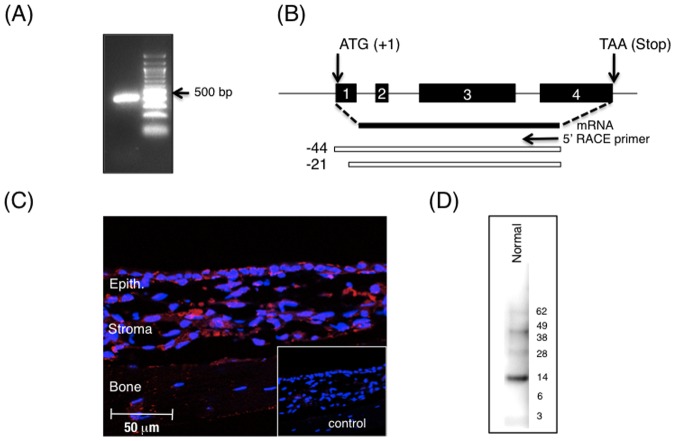
Ecrg4 is present in normal rat ME mucosa.
Panel A: Ecrg4 PCR product amplified from uninfected rat ME mucosa cDNAs. A 100 bp molecular size marker is shown on the left lane. Panel B: Organization of the rat Ecrg4 gene shows the 4 exons and the start (set to +1) and stop codons of the open reading frame (ORF). The mRNA isolated from rat ME mucosa was subjected to 5′RACE analysis using a primer annealing to exon 4 (solid arrow). Following primer elongation, cloning and sequencing of the 5′ RACE products (clear bars), translation start sites (TSS) at −42 bp and −21 bp upstream of the ATG translation start site produce the identical ORF. An asterisk denotes that the −21 bp TSS was the most frequently amplified. Panel C: Immunolocalization of Ecrg4 (red) in the ME epithelium compared to a background immunofluorescence signal using pre-immune IgY (insert). Nuclei are counterstained with DAPI (blue). Epith.  =  epithelial cells (D) Immunoblotting of rat ME mucosa revealed the presence of a prominent 14 kDa Ecrg4 protein band.